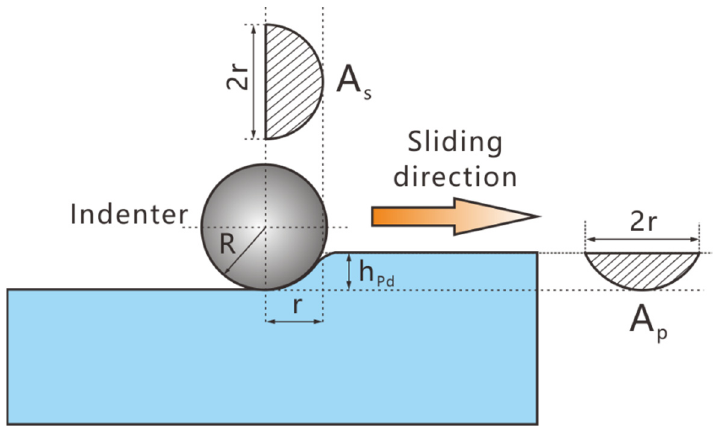
Figure 11. The schematic of indenter scratching on Cu – BCs.